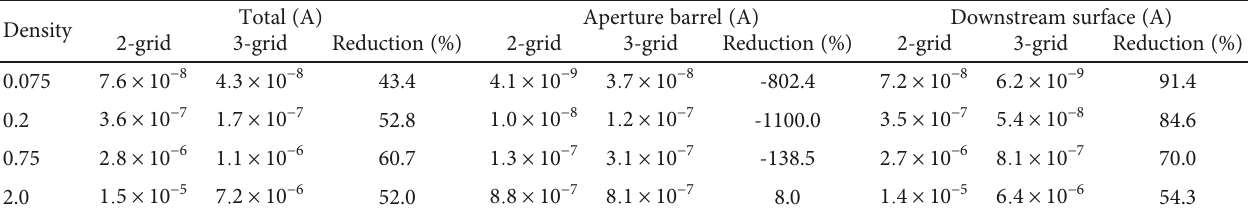
Table 10: The downstream re fl ux CEX ion impingement current of the accelerator grid and the reduction ratio. Density